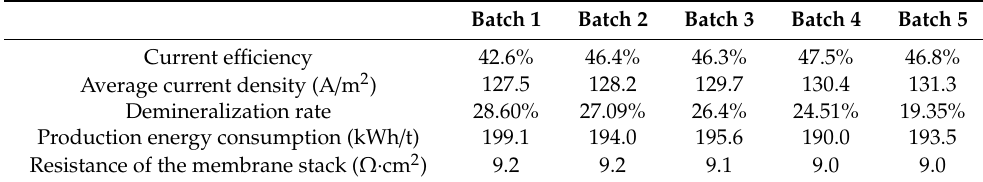
Figure 8. The current density in the demineralization of sodium gluconate mother liquor in batch 1 and batch 5. The conventional direct-current power and the pulse direct-current power operated at constant voltage of 9 V. Table 4. Pulse ED performance of sodium gluconate mother liquor.